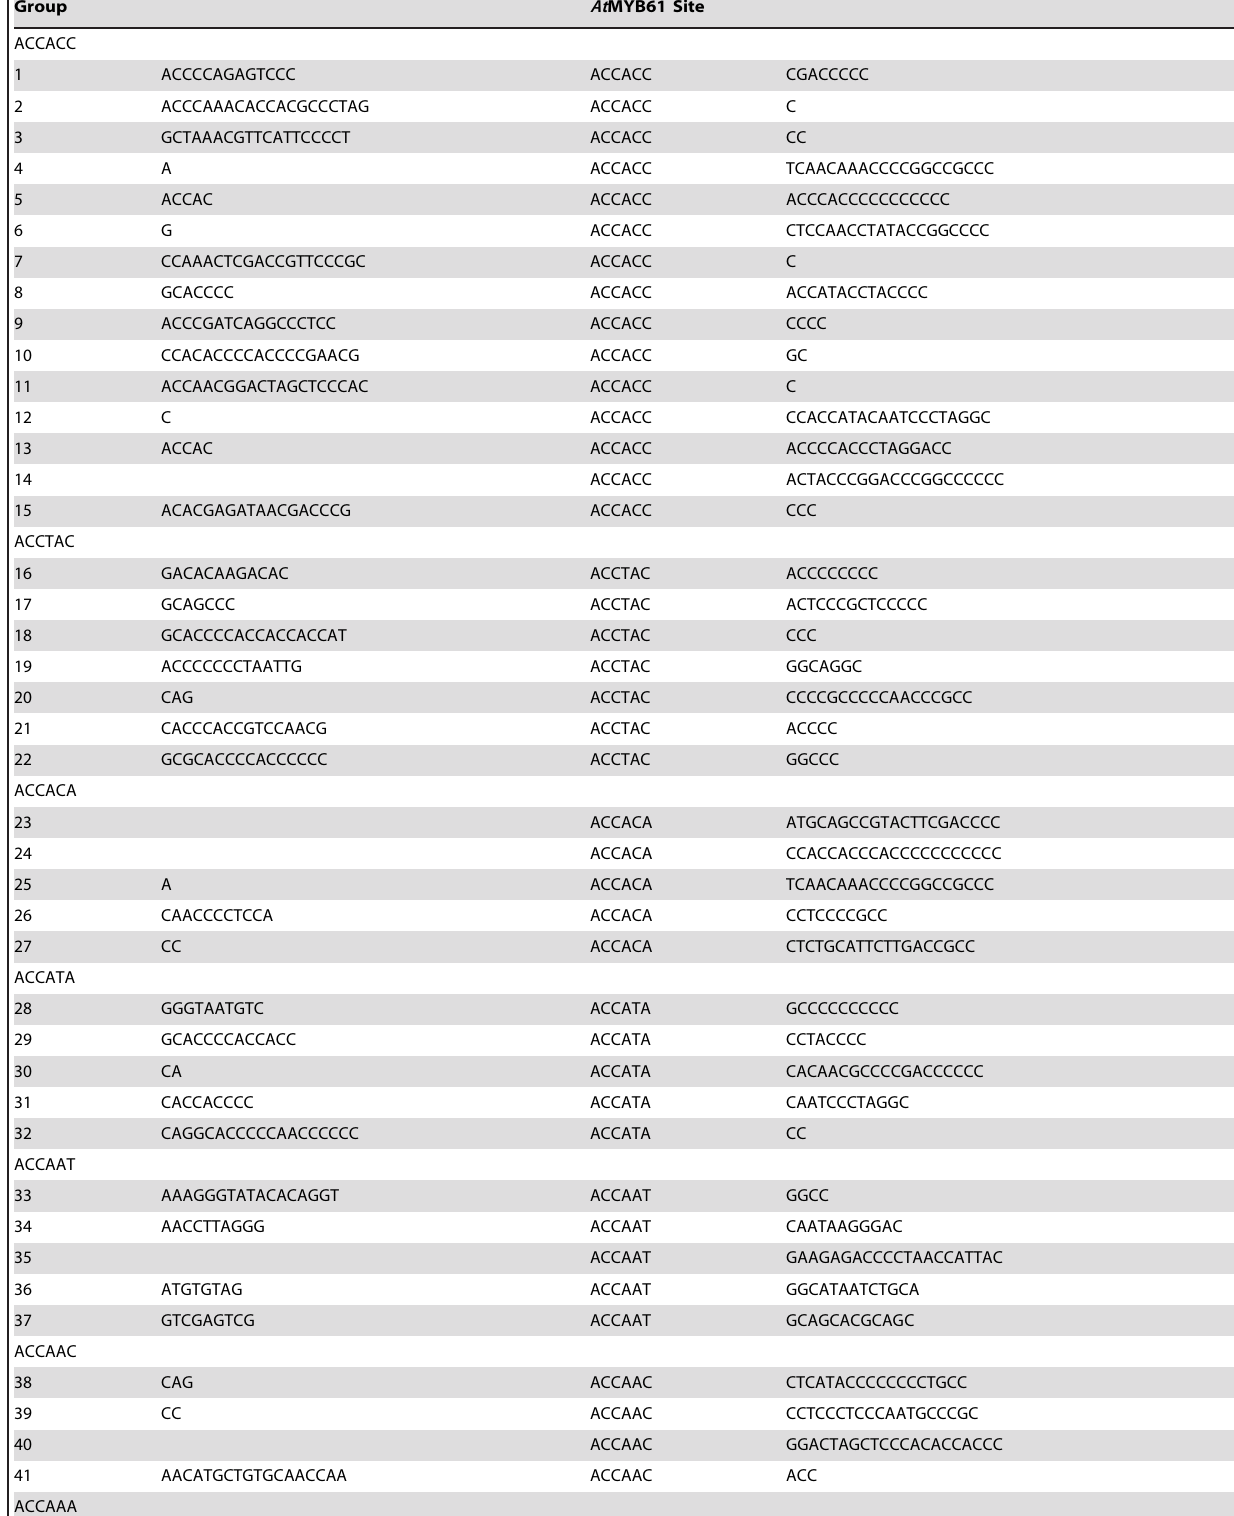
MEME (Multiple EM for Motif Elicitation) identified 7 over-represented hexamer